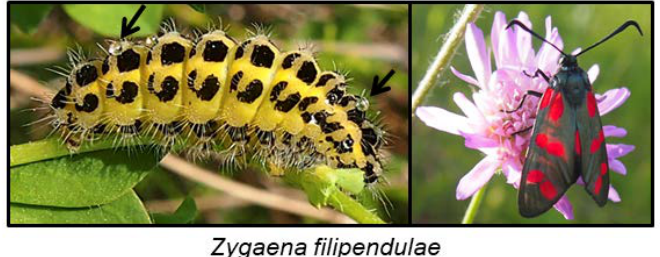
Figure 13. Z. filipendulae larva with defence droplets (arrows) and adult Z. filipendulae (photos by Mika Zagrobelny).